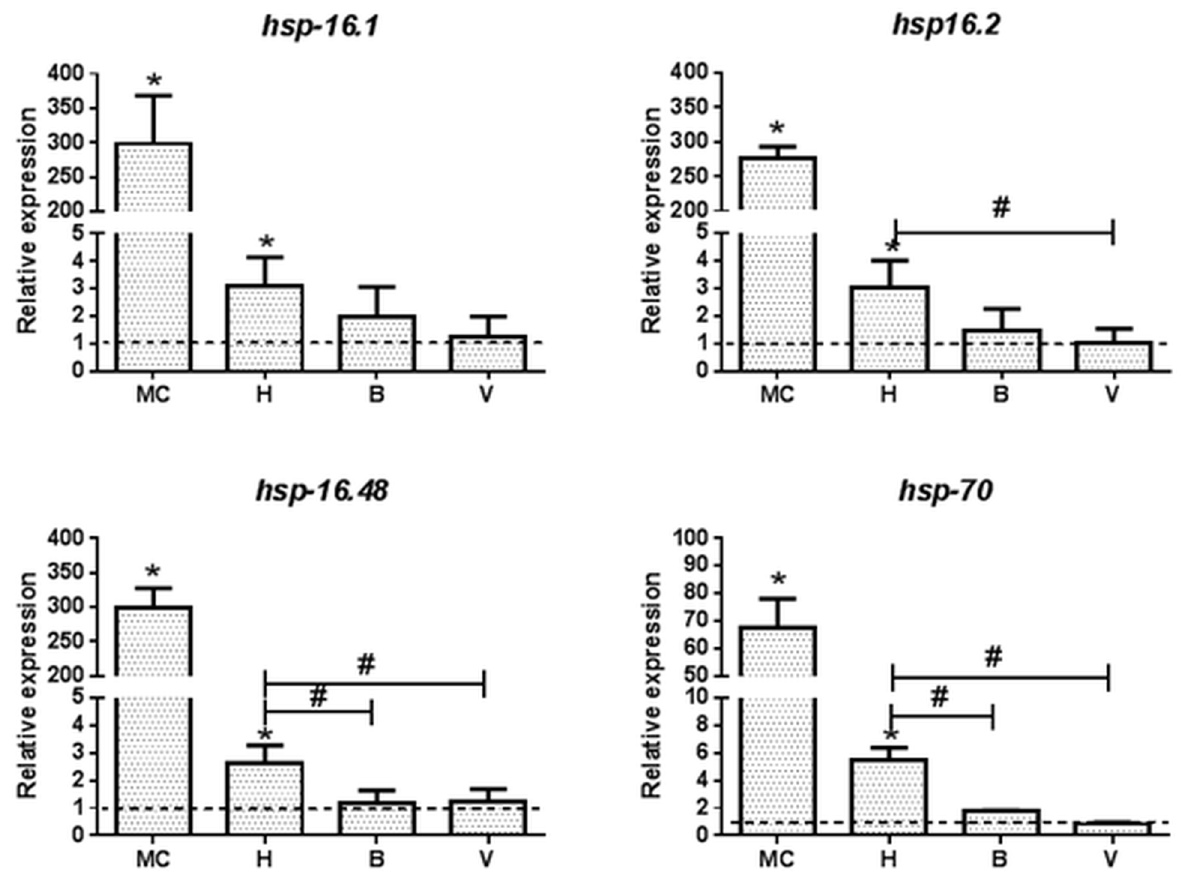
Fig 2. Metal exposure alters the expression of heat shock response genes in C . elegans . Synchronized young adult C . elegans were exposed for six hours to the metal cocktail (MC) or waters from Lake Hornträsket (H) and Vormbäcken stream at Björk å s (B) and the exit to Vindelälven (V). qRT-PCR was performed for genes hsp-16 . 1 , hsp-16 . 2 , hsp-16 . 48 and hsp-70 . One way analysis of variance (ANOVA) followed by Tukey ’ s post-test was used for multiple group comparison where * refers to p < 0.01 as compared to control, and # represents significant differences between the environmental sites H, B and V. The dotted line represents the expression level normalized to that of the control (K-medium prepared with Milli-Q water).